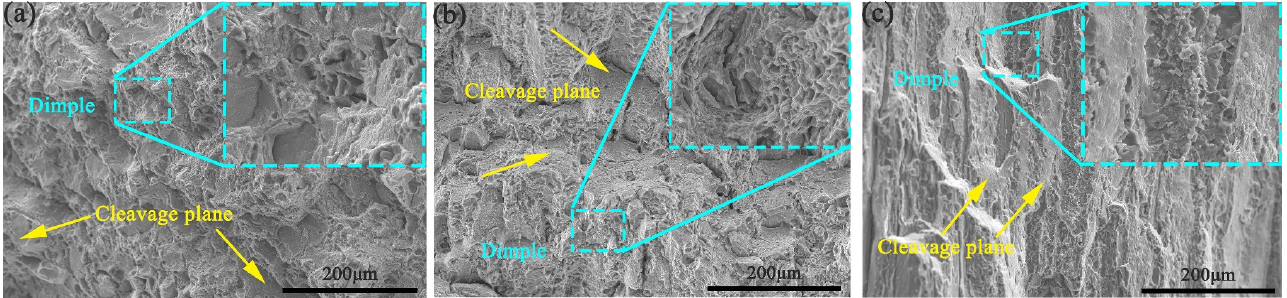
Figure 8. Tensile fracture morphologies of extruded 7075 Al alloy in different directions: ( a ) ED, ( b ) 45°, ( c ) RD.